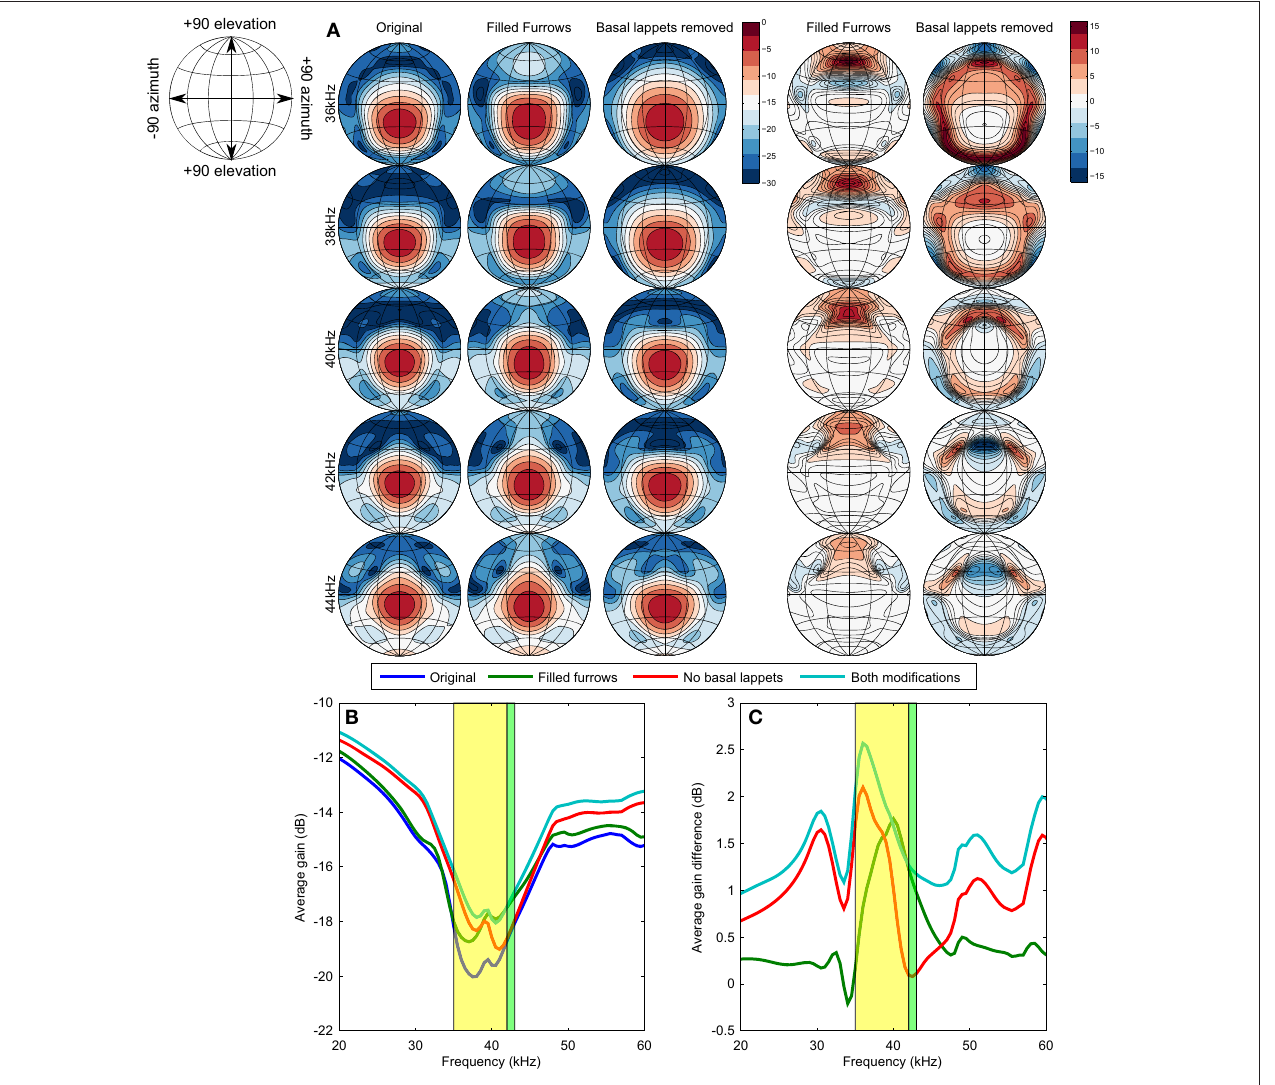
FIGURE 3 | (A) Simulated emission beam patterns for the original model and the models with filled furrows or without flaps (contours are spaced 3 dB apart). The two right most columns show the difference in gain ( ¯ g ) between the original model and the two altered models (contours are spaced 1dB apart). (B) Average gain of the emission beam pattern as function of frequency. The frequency ranges of both the FM and the CF